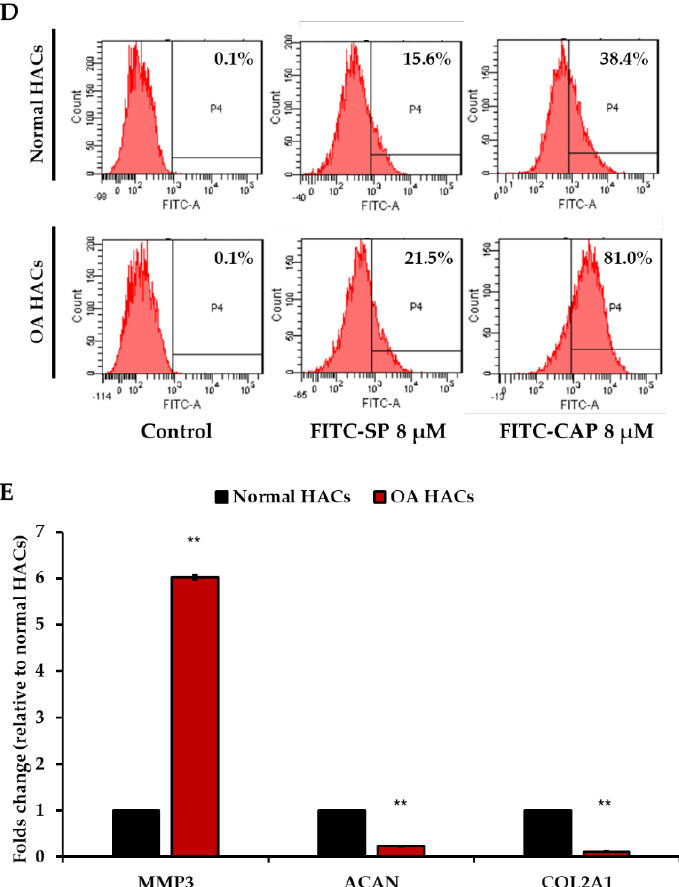
Figure 2. ( A ) Morphology of HACs observed under a phase contrast microscope. ( B ) Flow cytometric analysis of FITC- positive cells. Primary HACs from donors of various ages, from 11 to 54 years old, were incubated with FITC-CAP or FITC-SP, and binding affinity was analyzed by flow cytometry. ( C ) Percentage of FITC-CAP- and FITC-SP-positive HACs. ( D ) Binding affinity of FITC-CAP and FITC-SP on normal HACs and OA HACs. ( E ) Expression of OA gene markers in HACs isolated from non-pathologic and osteoarthritic lesions. Results are shown as mean ± SEM. * p < 0.05 and ** p < 0.01. Experiments were repeated 5 times ( n = 5).